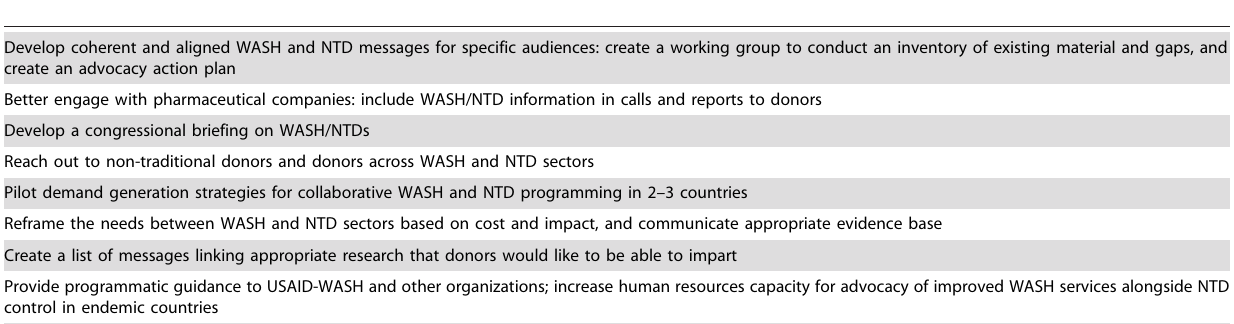
Table 4. Opportunities and next steps in advocacy for WASH and NTD